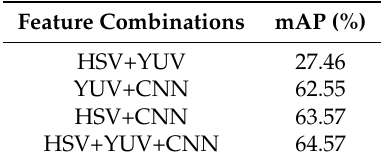
Figure 4. Comparison of the precision by three fusion on Holidays datasets. Table 2. Comparison with different fusion precision on Holidays.